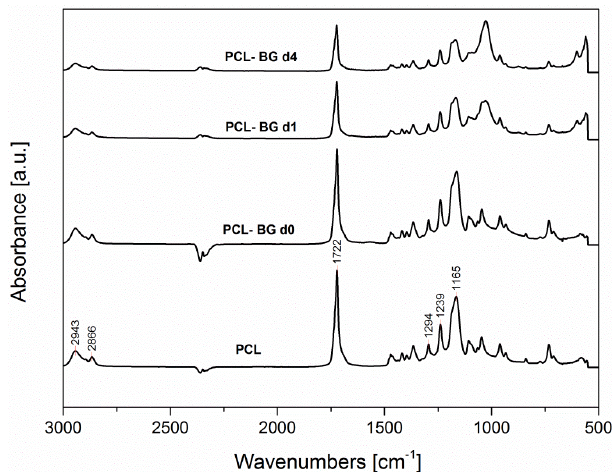
Figure 9. Fourier transform infrared spectroscopy (FTIR) spectra in the range 3000–500 cm −1 for electrospun samples of neat PCL (PCL), PCL with BG particles before immersion in SBF solution (PCL-BG d0) and after one day (PCL-BG d1) and four days (PCL-BG d4) of immersion in SBF solution (the characteristic peaks are discussed in the text).